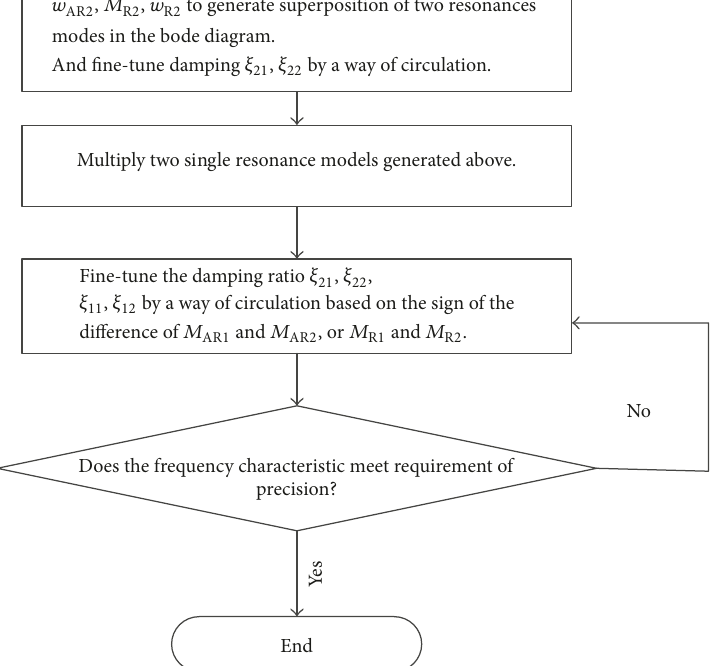
this paper, the numerical model of this resonance mode can be gotten by